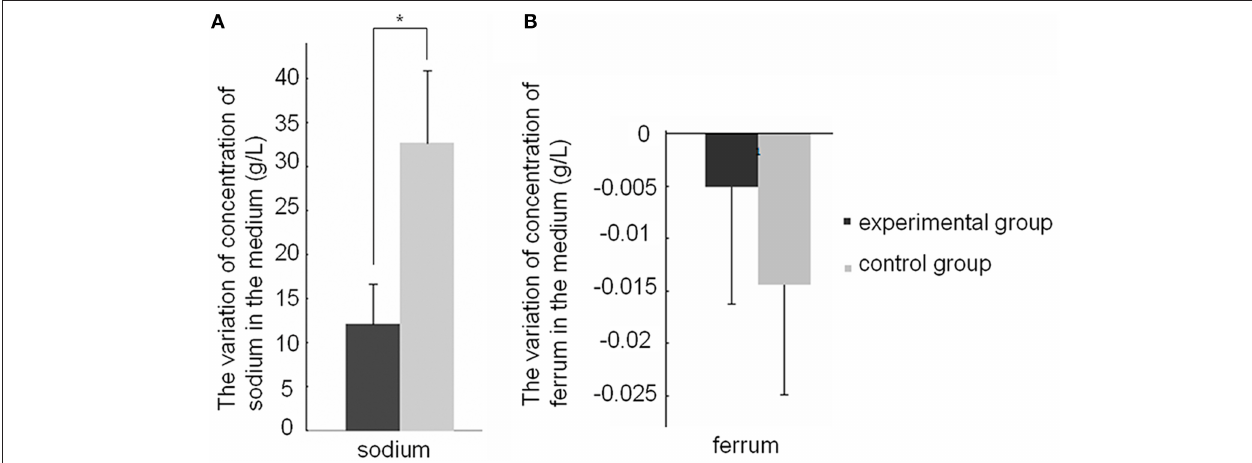
FIGURE 3 | Effect of the SWU1 infection on sodium and ferrum fluxes. (A) Positive value stands for the concentration of ions increased after SWU1 infected 30min. (B) Negative value stands for the concentration of ions decreased after SWU1 infected 30min. The capacity of sodium efflux was suppressed after SWU1 infected. Iron uptake system was disrupted by SWU1. The data were averaged from two independent experiments ± s.d. Significant differences ( * p < 0.05 ).